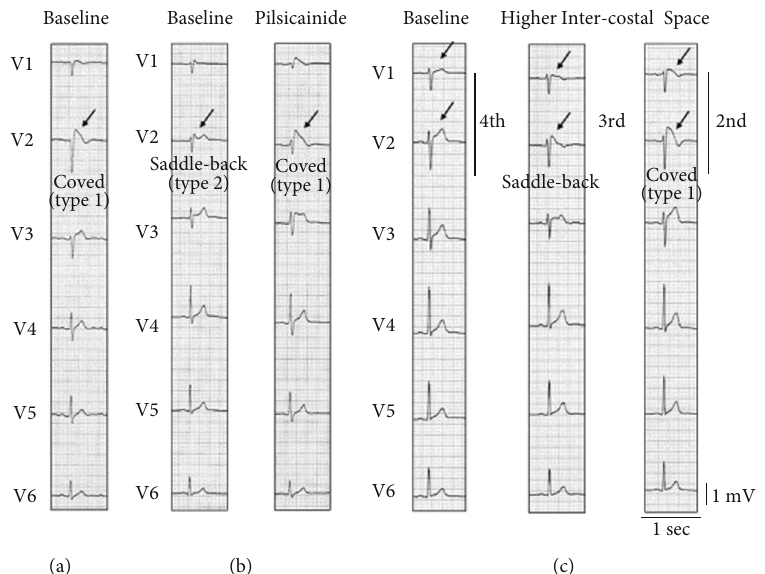
Figure 2: Brugada syndrome ECGs. (a) Spontaneous type 1 ST-segment elevation. (b) Unmasking of ST-segment elevation by a pharmacological sodium channel blocker, pilsicainide. Under baseline condition, type 2 ST-segment elevation is recorded in lead V2. Pilsicainide injection (30 mg) unmasks type 1 electrocardiogram (ECG) in lead V2. (c) Unmasking of type 1 ECG by recordings of right precordial (V1 – V2) leads at the third and second intercostal spaces. Adapted and reprinted with permission from